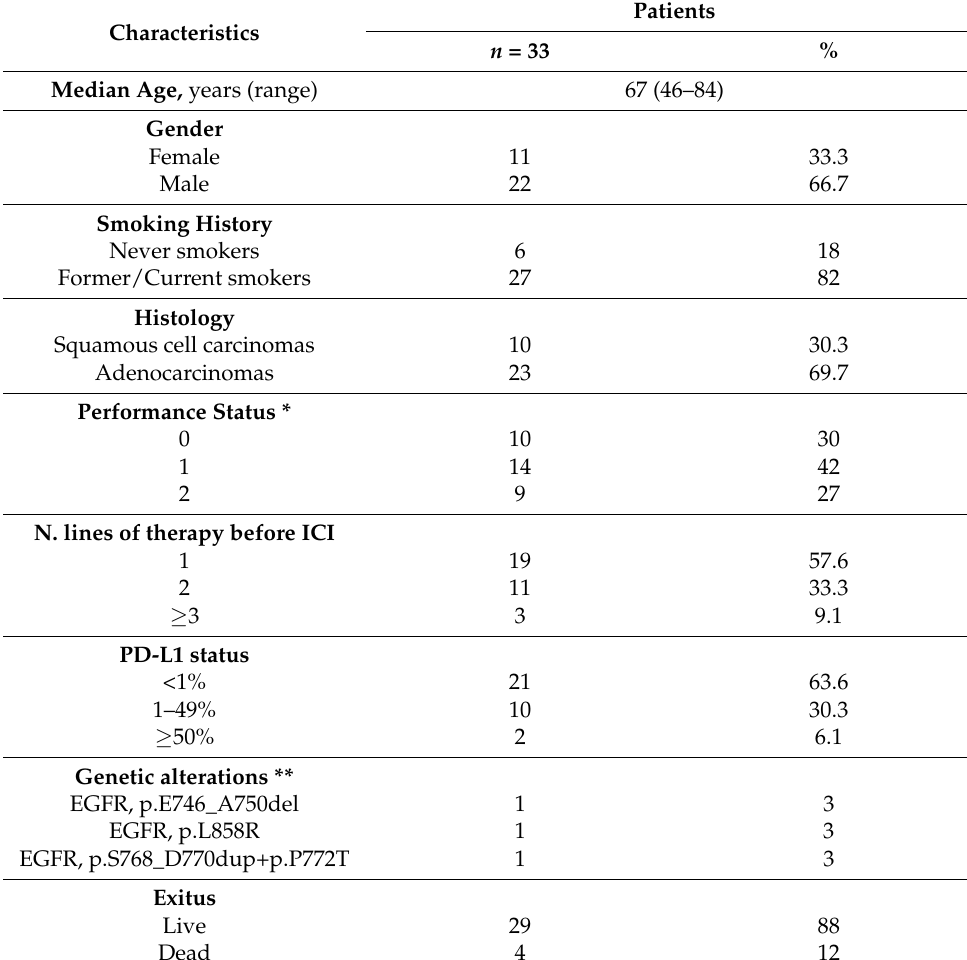
Table 1. Clinicopathological characteristics of the